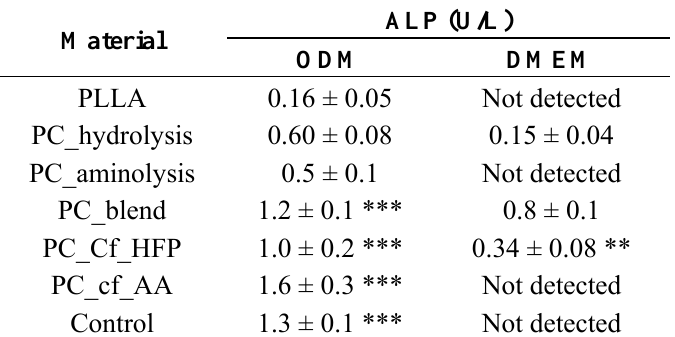
Figure 3. Incorporation of 3 H-thymidine (CPM) into the DNA of SHEDs after ( A ) 0; ( B ) 3; ( C ) 7; ( D ) 10; and ( E ) 14 days of culture on different PLLA and collagen scaffolds. Statistically significant difference at * p < 0.05, ** p < 00.01 and *** p < 00.001. Table 5. ALP activity (U/L) means and standard deviations in SHEDs cultured on scaffolds under ODM and DMEM